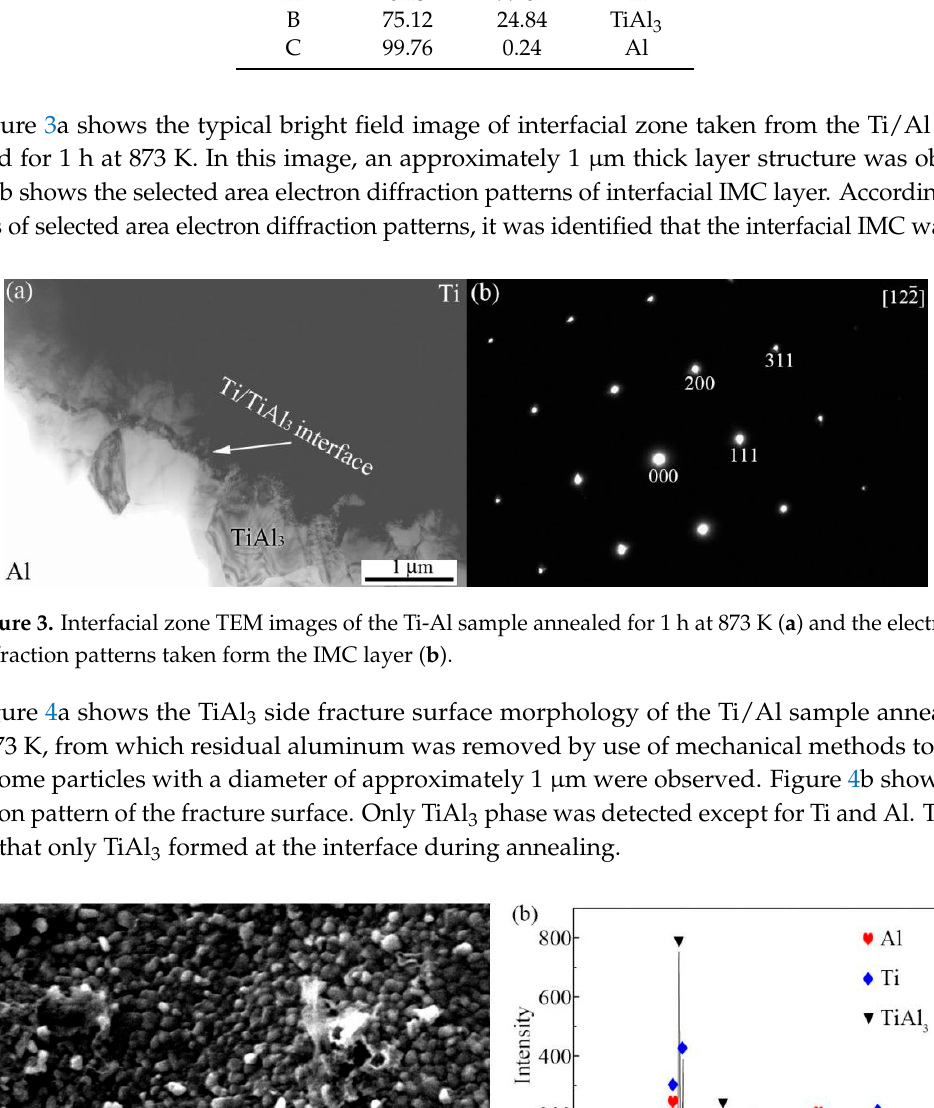
Table 2. Composition of points in Figure 2(c) by EDX.